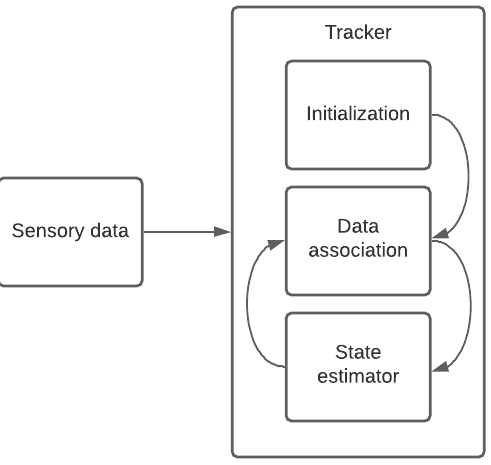
Figure 1. A framework to represent the place of the data association’s